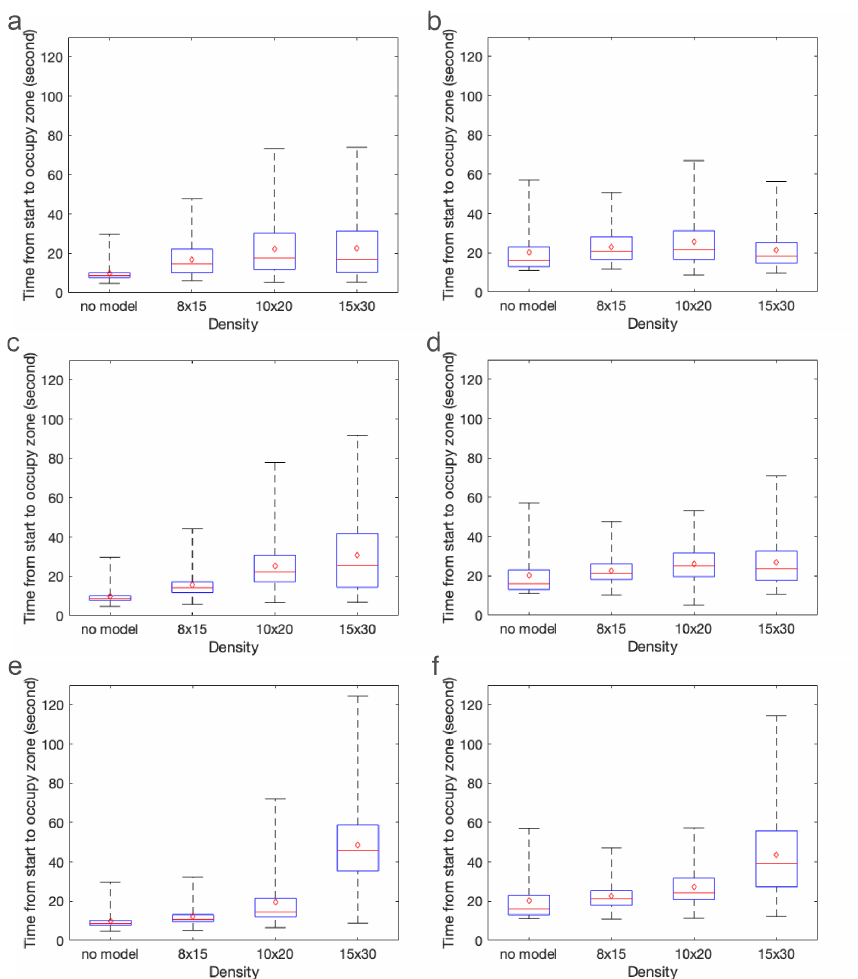
Figure 10. Box plots showing the mean (red dot), median (red line), upper and lower quartiles, and typical times from the start of the experiment when the brine shrimp appear in the green (left) and blue (right) zones. The panels show cylinder heights set equal to: 1 cm ( a , b ); 2 cm ( c , d ); and 3 cm ( e , f